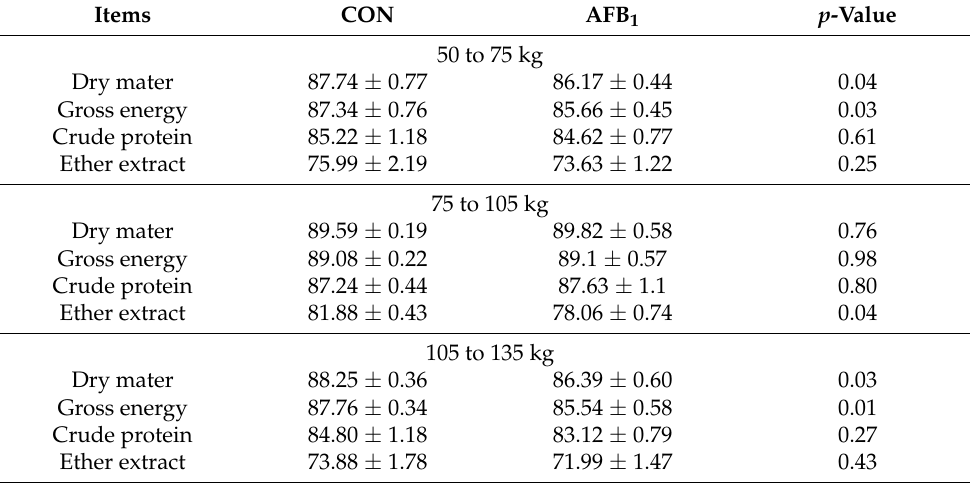
Table 6. Effects of AFB 1 on the apparent total tract digestibility of pigs (%).